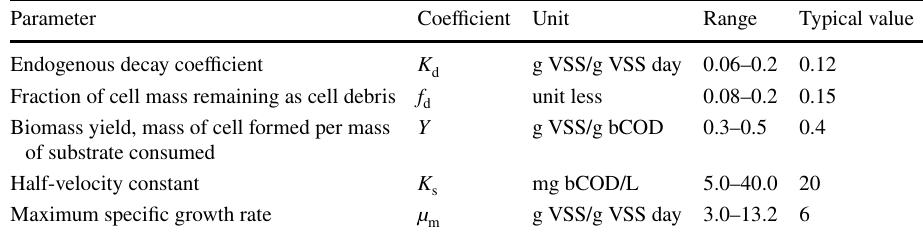
Table 2 Activated sludge kinetic coefficients (Eswaramoorthi et al.